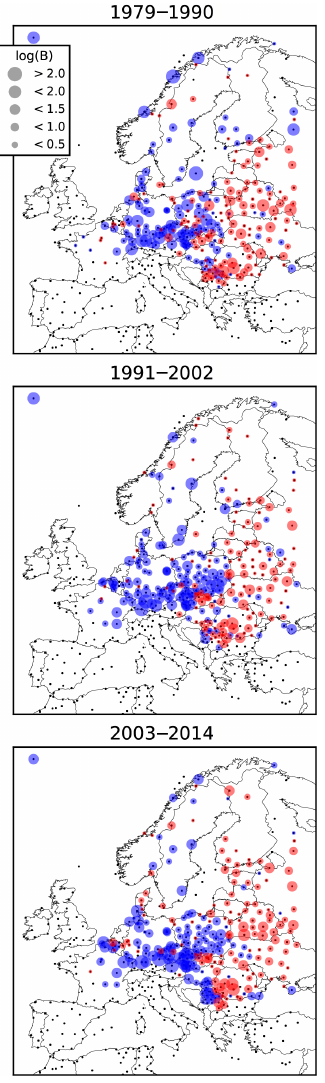
Figure 4. Logarithm of bias B of the FMI CLIM results in differ- ent 12-year periods. Blue (red) shows the overestimation (underes- timation) of predicted total number FZRA events compared to the observations. Sizes of markings indicate the magnitude of